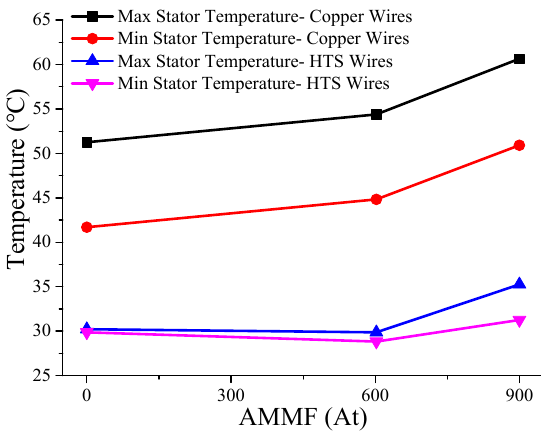
Figure 21. Comparisons of the stator temperature of the machine developed by copper wires and HTS wires.